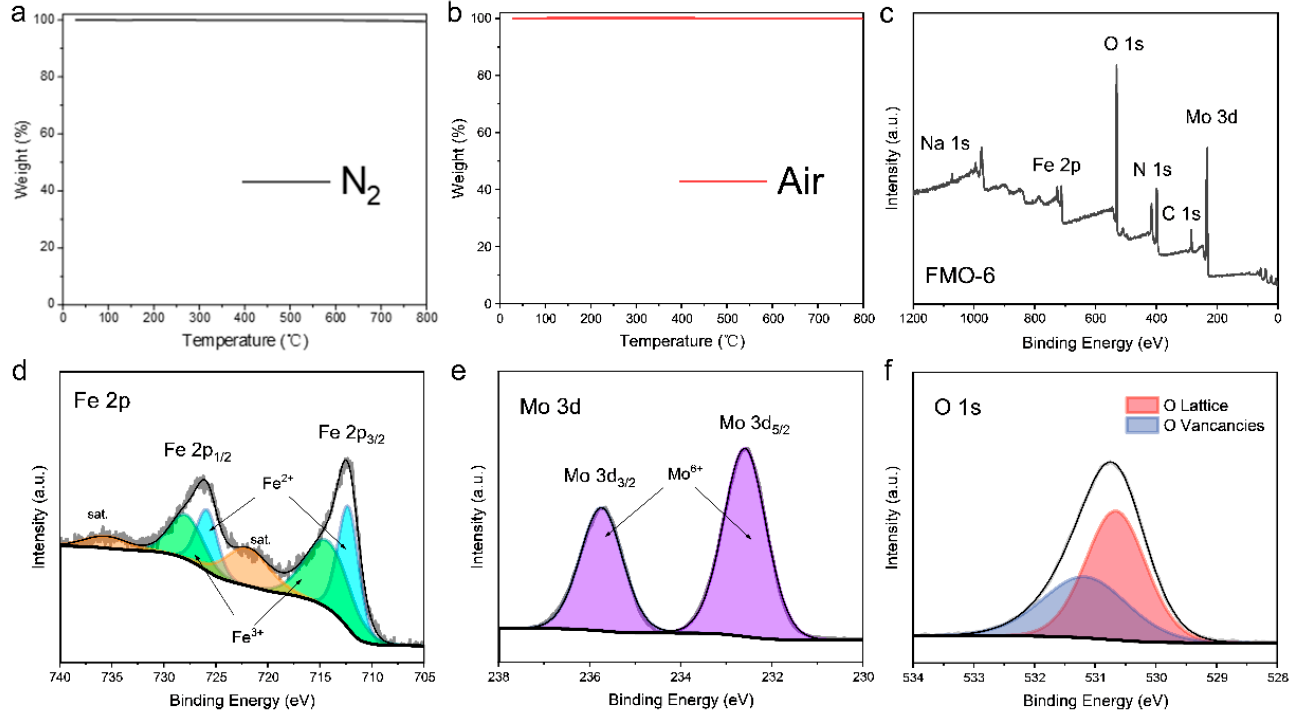
Figure 3. ( a ) TGA analysis of FMO-6 conducted in N 2 ; ( b ) TGA analysis of FMO-6 conducted in air; ( c ) full XPS spectrum of FMO-6; high-resolution XPS spectra showing ( d ) Fe 2p, ( e ) Mo 3d, and ( f ) O 1 s binding energies of FMO-6.